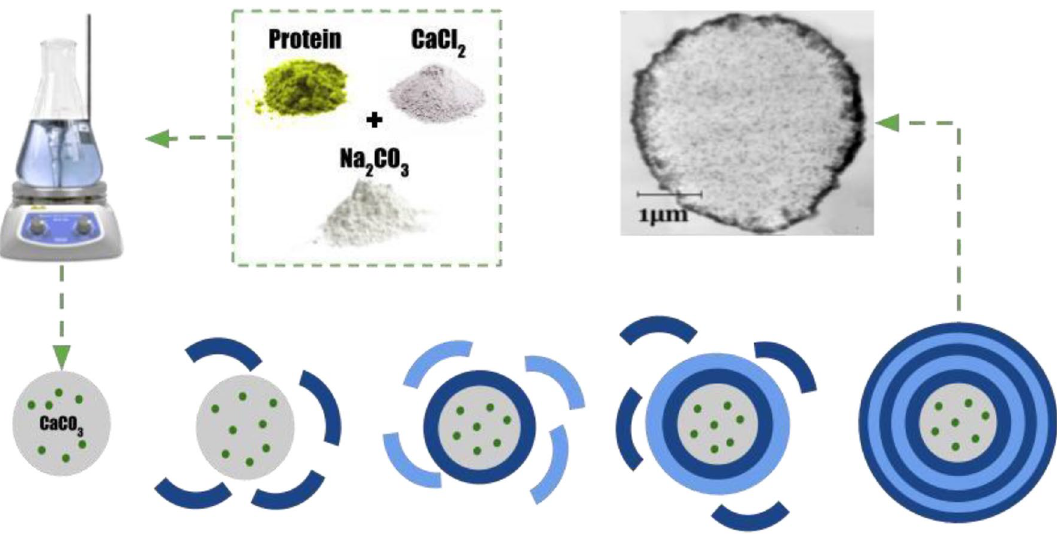
Figure 2. Stages of polyelectrolyte microcapsules